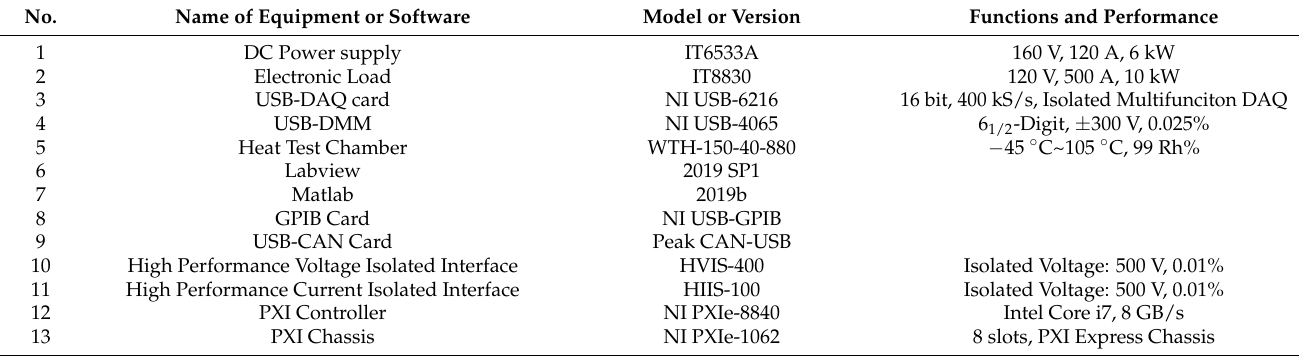
Table 1. The equipment and software